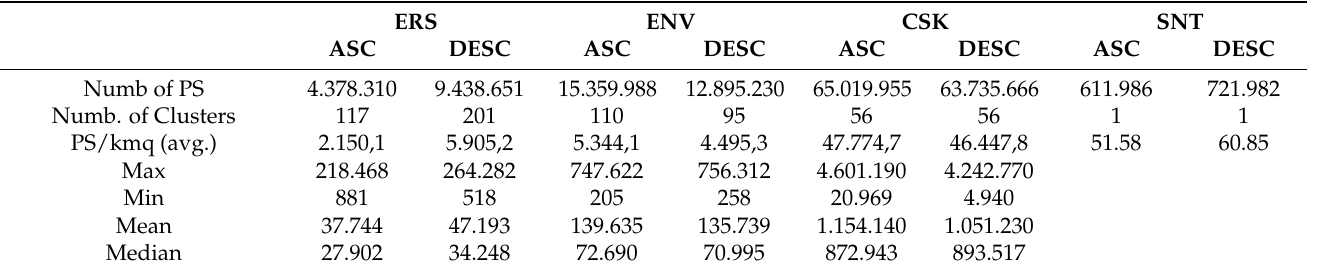
Table 1. Surface statistics for the clusters of the four satellite missions of the MATTM database (ERS, ENV and CSK) and the MEMPHYS database